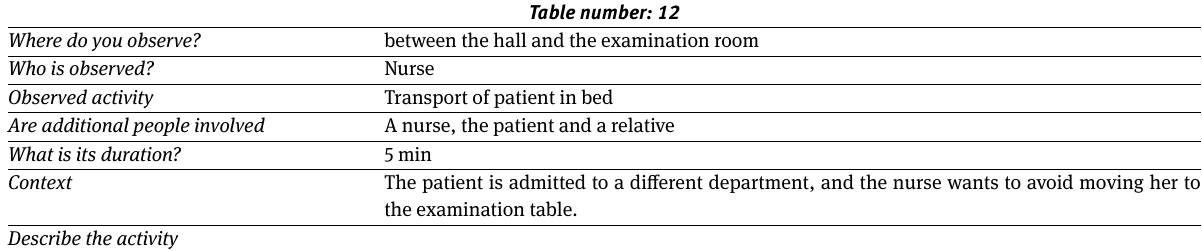
Table 4: Report number 47, table number 12 from evening observation at the Department of Cardiology. The corresponding categorization of this process is provided in Figure